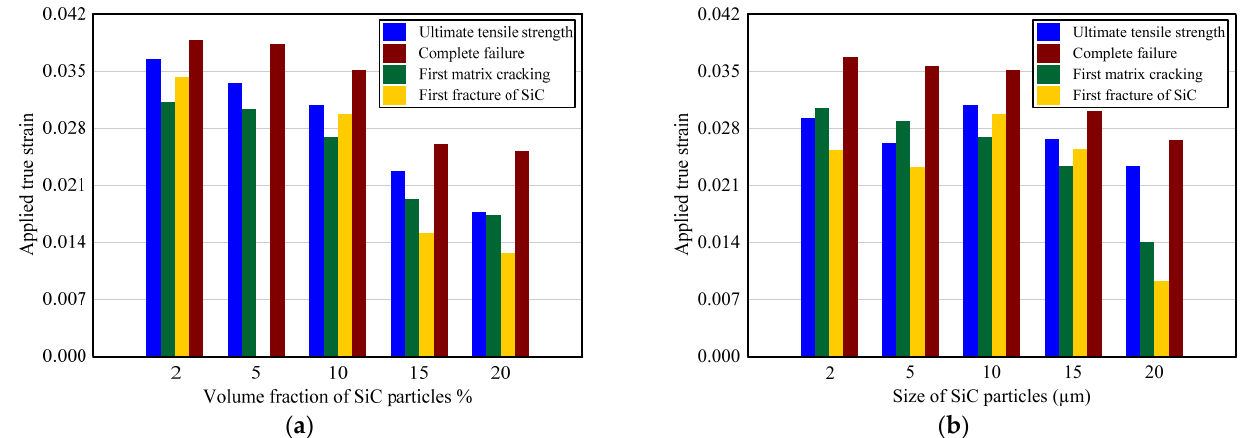
Figure 19. Variation of the applied true strain required for the onset of each failure mode and complete failure: ( a ) effect of VF; ( b ) effect of PS.